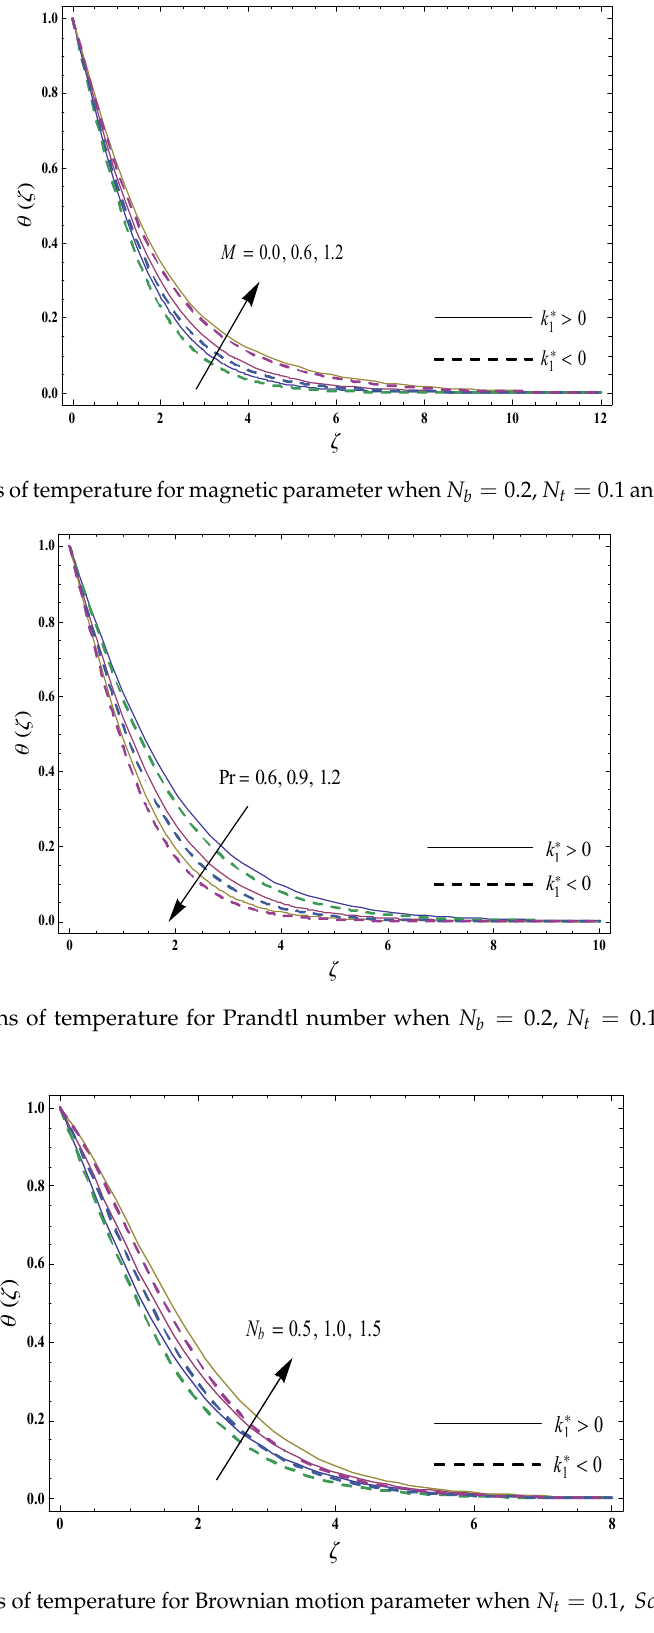
M = Pr = 1  0 and  = 0  2 